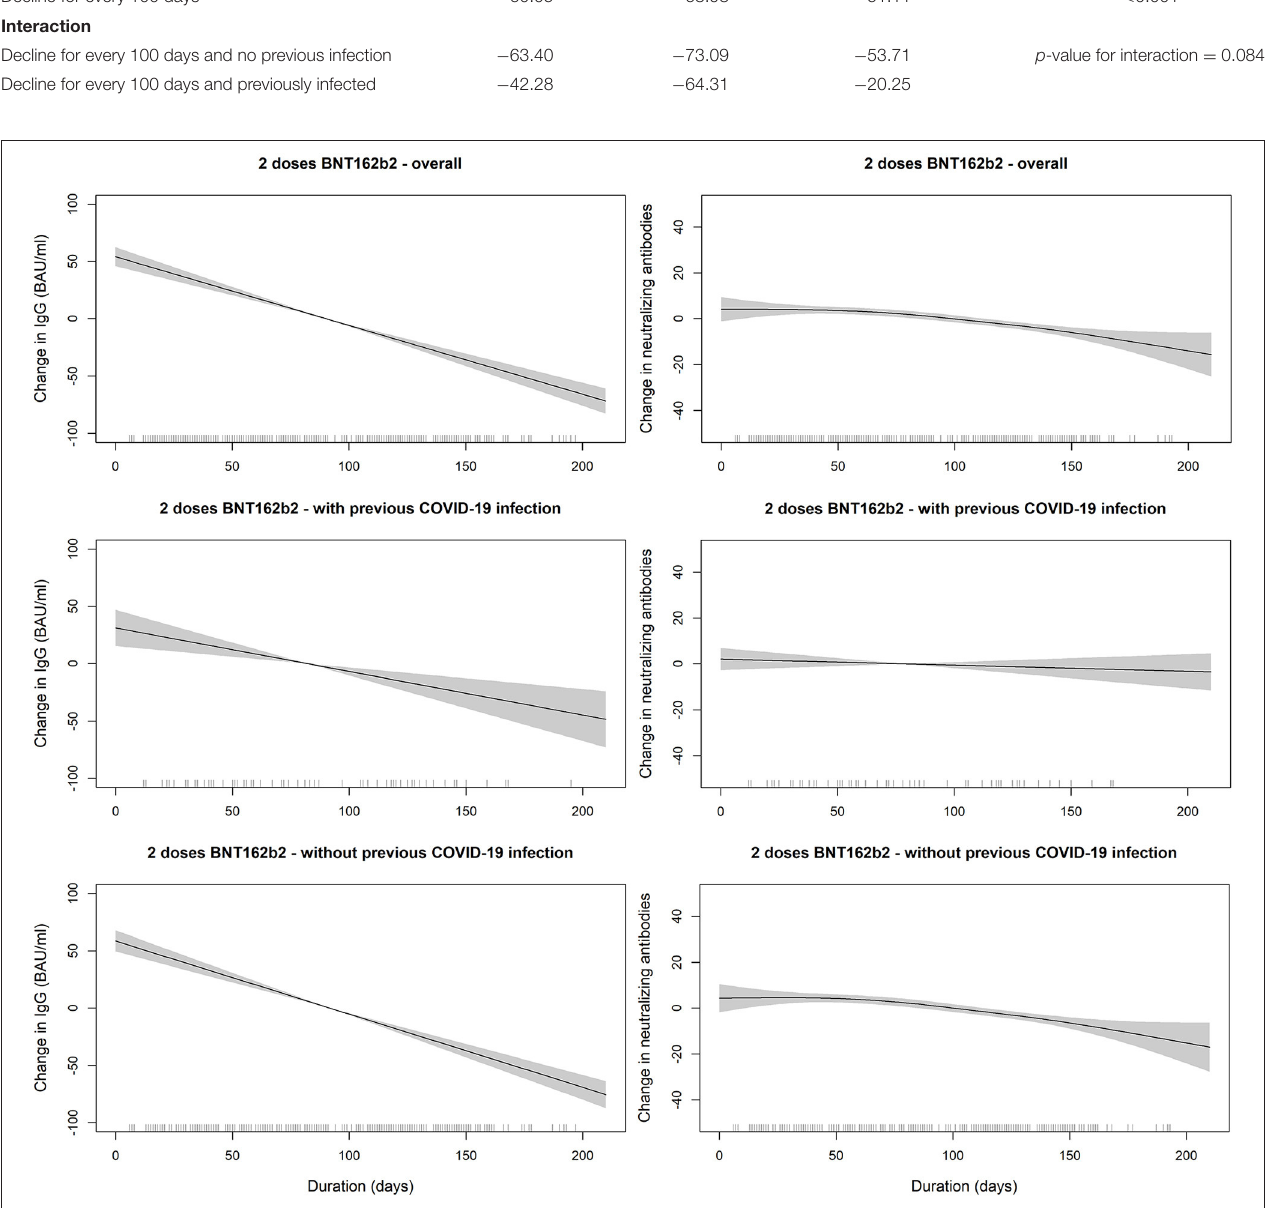
FIGURE 3 | SARS-COV2 IgG and neutralizing antibodies decline over time since receiving the second dose of BNT162b2 (Pfizer–BioNTech) vaccine stratified by previous COVID-19 infection status. The smooth relationships were derived from generalized additive models with penalized splines for duration (in days) and adjusted for age, gender, BMI, and comorbidity scores. Solid lines represent the effect estimates of change over time while the shaded areas represent the 95% confidence intervals. The graphs show faster decline for both markers in vaccinated individuals without previous COVID-19 infection in comparison to those with previous infection.